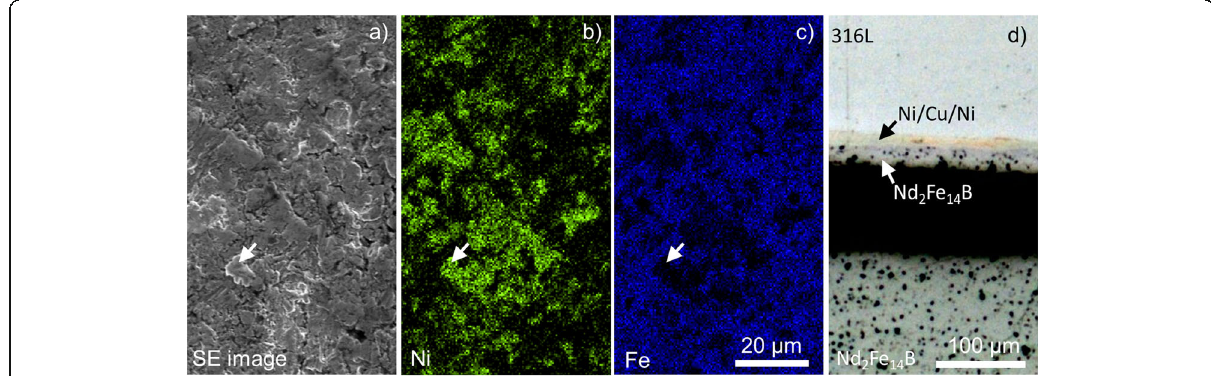
Fig. 10 Scanning electron microscopy and energy dispersive X-Ray (EDX) mappings of a fracture surface of a 316L/NdFeB showing the 316L surface a secondary electron image b EDX mapping of Nickel c EDX mapping of Fe and d the microsection of a failed 316L/NdFeB joint